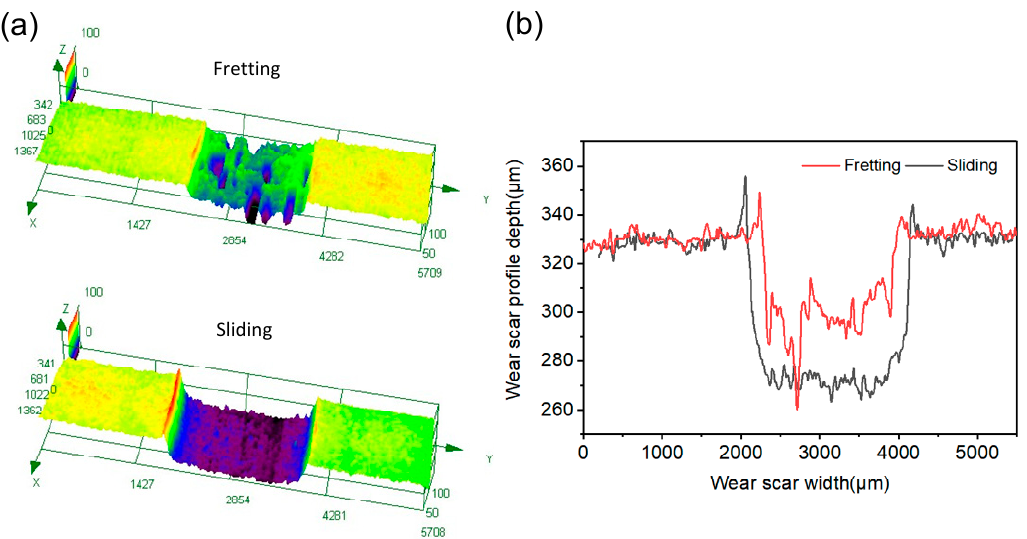
Figure 4. Cross-sectional profiles of the fretting and sliding worn traces: ( a ) 3D profiles; ( b ) 2D profiles.